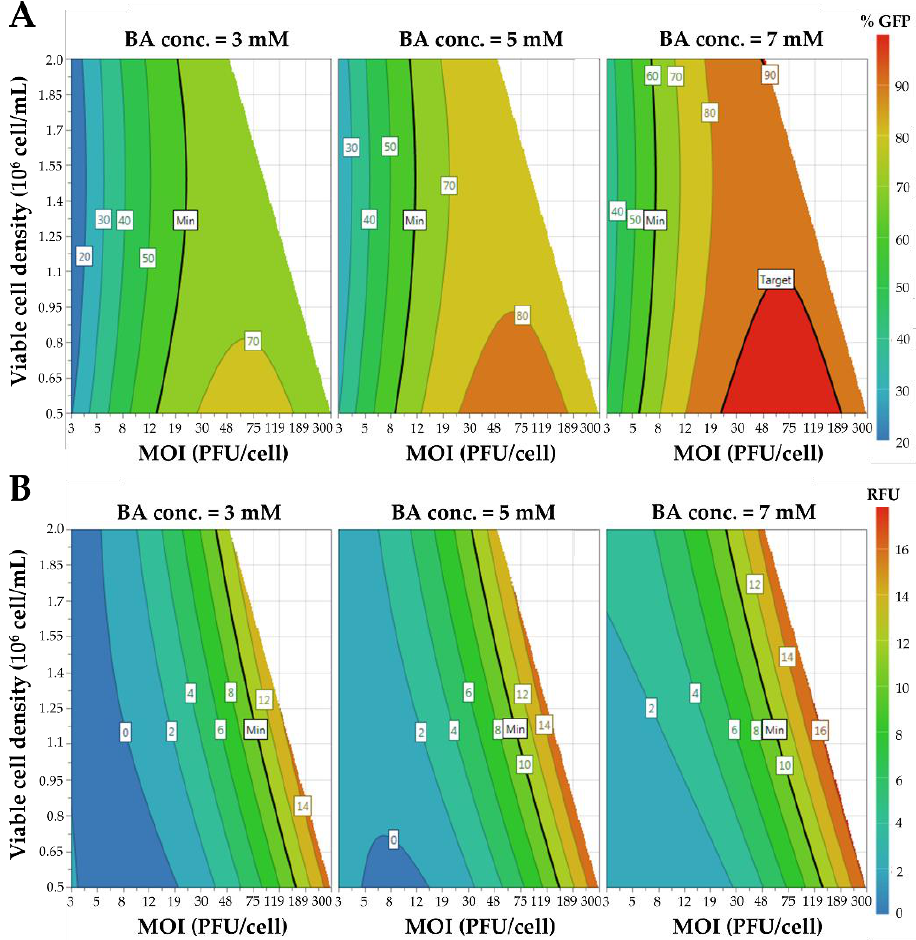
Figure 2. Contour plots of the different functions based on the D-optimal design. ( A ) Effect of VCD and MOI on HEK293 cell transduction efficiency at different BA concentrations. ( B ) Assessment of VCD and MOI on VLP production at different BA concentrations. BA: butyric acid, MOI: multiplicity of infection.